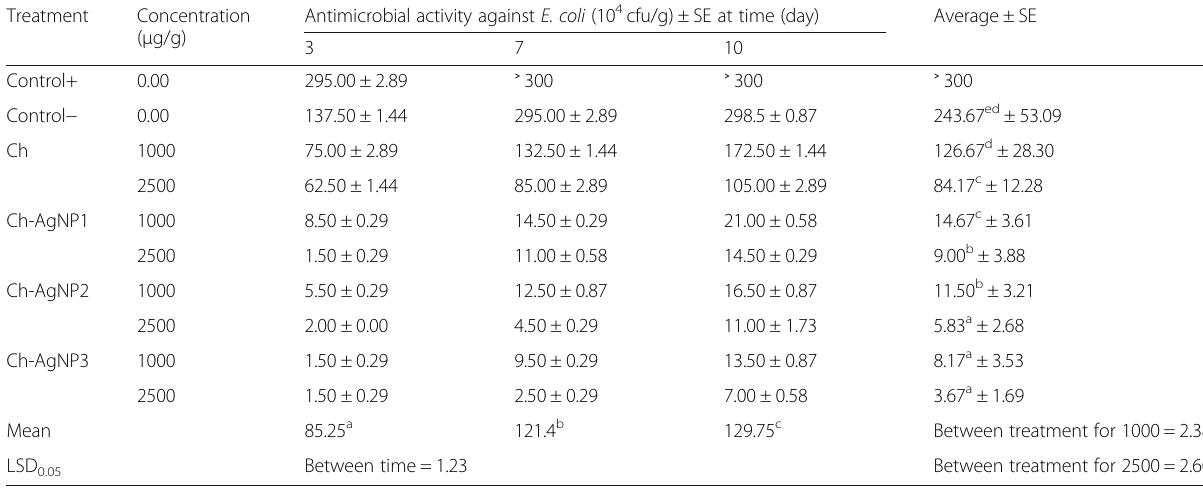
Table 3 In vivo antibacterial activity against E. coli (10 4 cfu/g) in minced beef meat products treated with chitosan (Ch) and chitosan-silver nanoparticles (Ch-AgNPs) after storage for 10 days at 4 °C Treatment